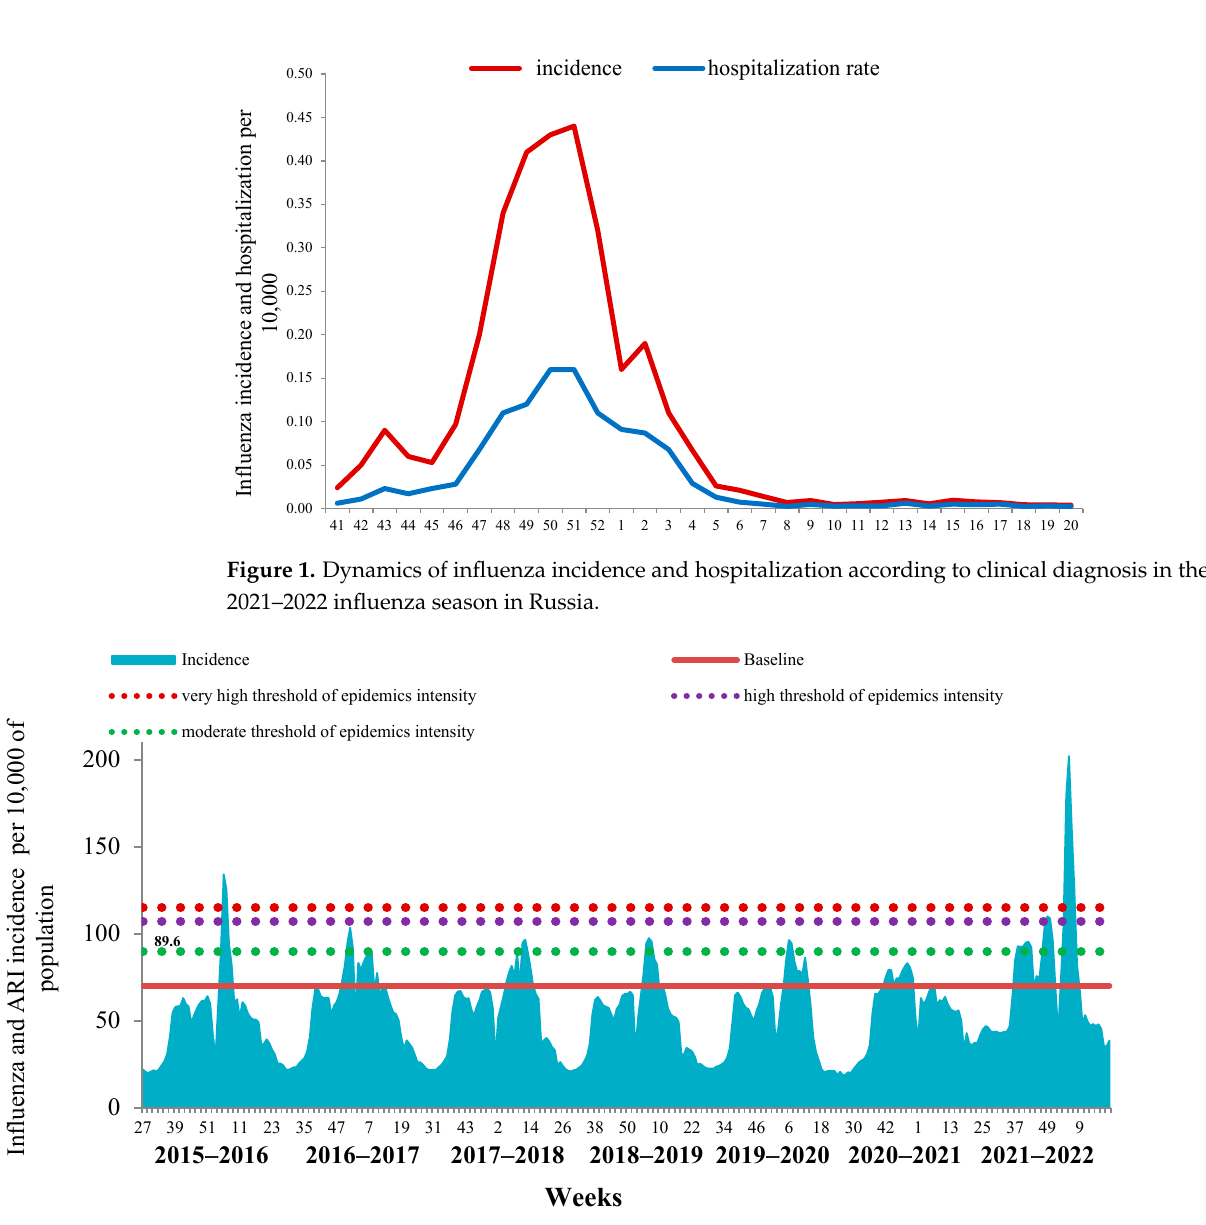
Figure 2. Dynamics of influenza and ARI cumulative incidence in the Russian Federation over the 7-year period.